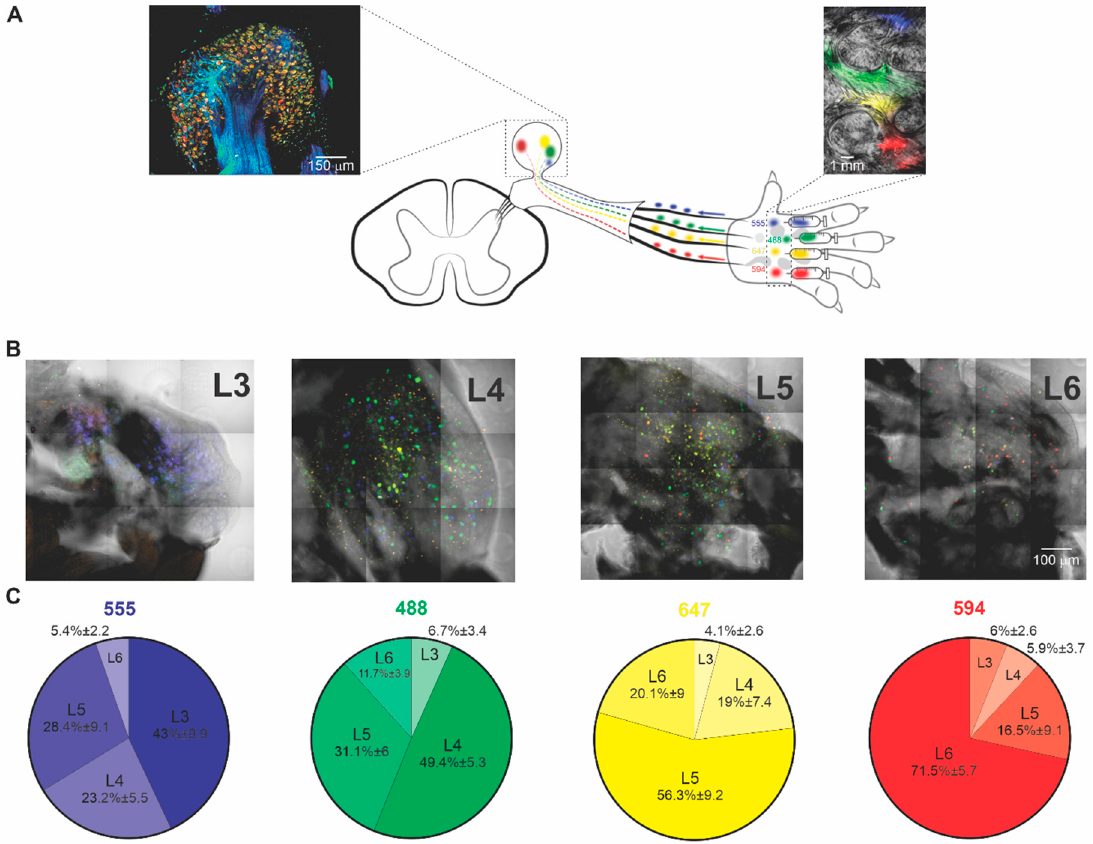
Figure 1. Retrograde labeling of dorsal root ganglion (DRG) somata that innervate distinctive areas of the paw. ( A ) Scheme depicting the Painbow approach. Four spectrally different fluorophores AF 488—green, AF 555—blue, AF 594—red, AF 647—yellow, conjugated to wheat germ agglutinin (WGA), were injected into the paw in the illustrated order. The dyes were uptaken by the axonal terminals innervating the injected paw skin and transported to DRG somata. The labeling of the specific DRG reflects the area in the paw this DRG innervates. Left inset, a high-resolution confocal fluorescent image of L 5 DRG excised 40 h after injecting the dyes into the skin. Right inset, the fluorescent image of the dissected paw skin obtained 40 h after the dye injection. Note that colors remained in the paw 40 h after the injection, allowing the correlation between the skin area and labeled DRG somata. Note di ff erently labeled somata of DRG neurons. ( B ) Collaged fluorescent photomicrography of representative individual L 3 -L 6 DRGs excised from naïve rats. Colored dots are DRG somata, retrogradely labeled from their innervation targets. ( C ) Distribution of injected dyes among lumbar DRGs of naïve rats. Note that as expected form the innervation patterns, AF555 injected into the medial part of the paw is mainly present in L 3 DRG; AF488 injected laterally to AF555 is mainly present in L 4 DRG; AF647 injected into the middle of the paw is mainly present in L 5 DRG, and AF594 injected into the lateral paw is mainly present in L 6 DRG. Data from five DRGs for each level from 5 rats, chi-square independence test (9) = 236.58, p < 0.001, suggesting that the DRG segments and the distribution of the colors are not independent of each